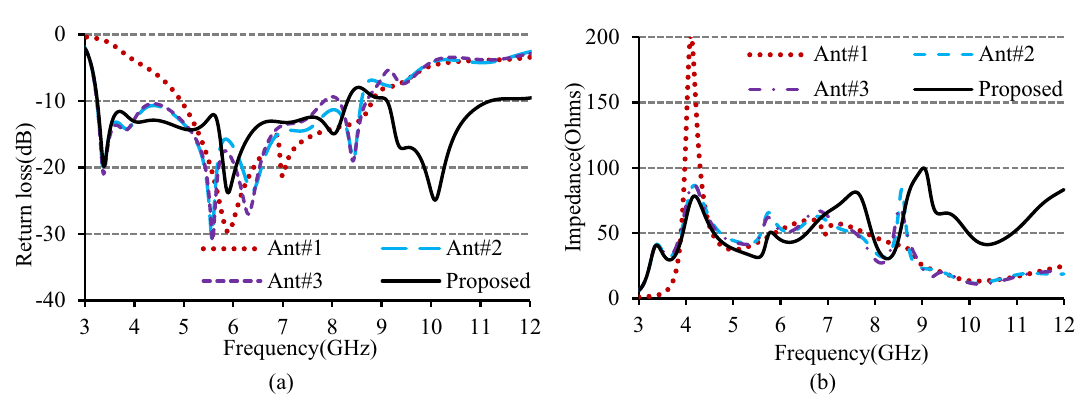
Figure 4. ( a ) Return loss curves, and ( b ) input impedances for the different evolution